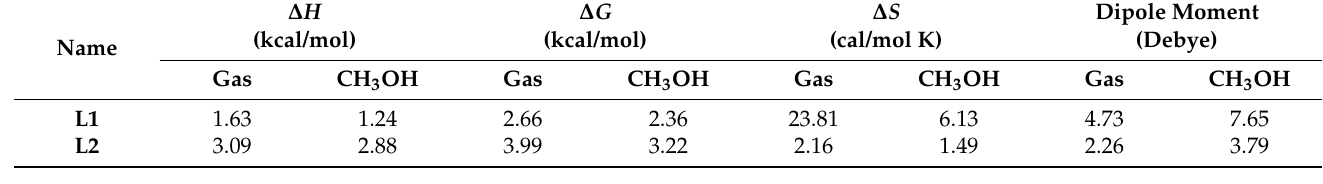
Table 3. Thermodynamic properties of both the reactions with dipole moments of L1 and L2 in the gas phase and methanol.